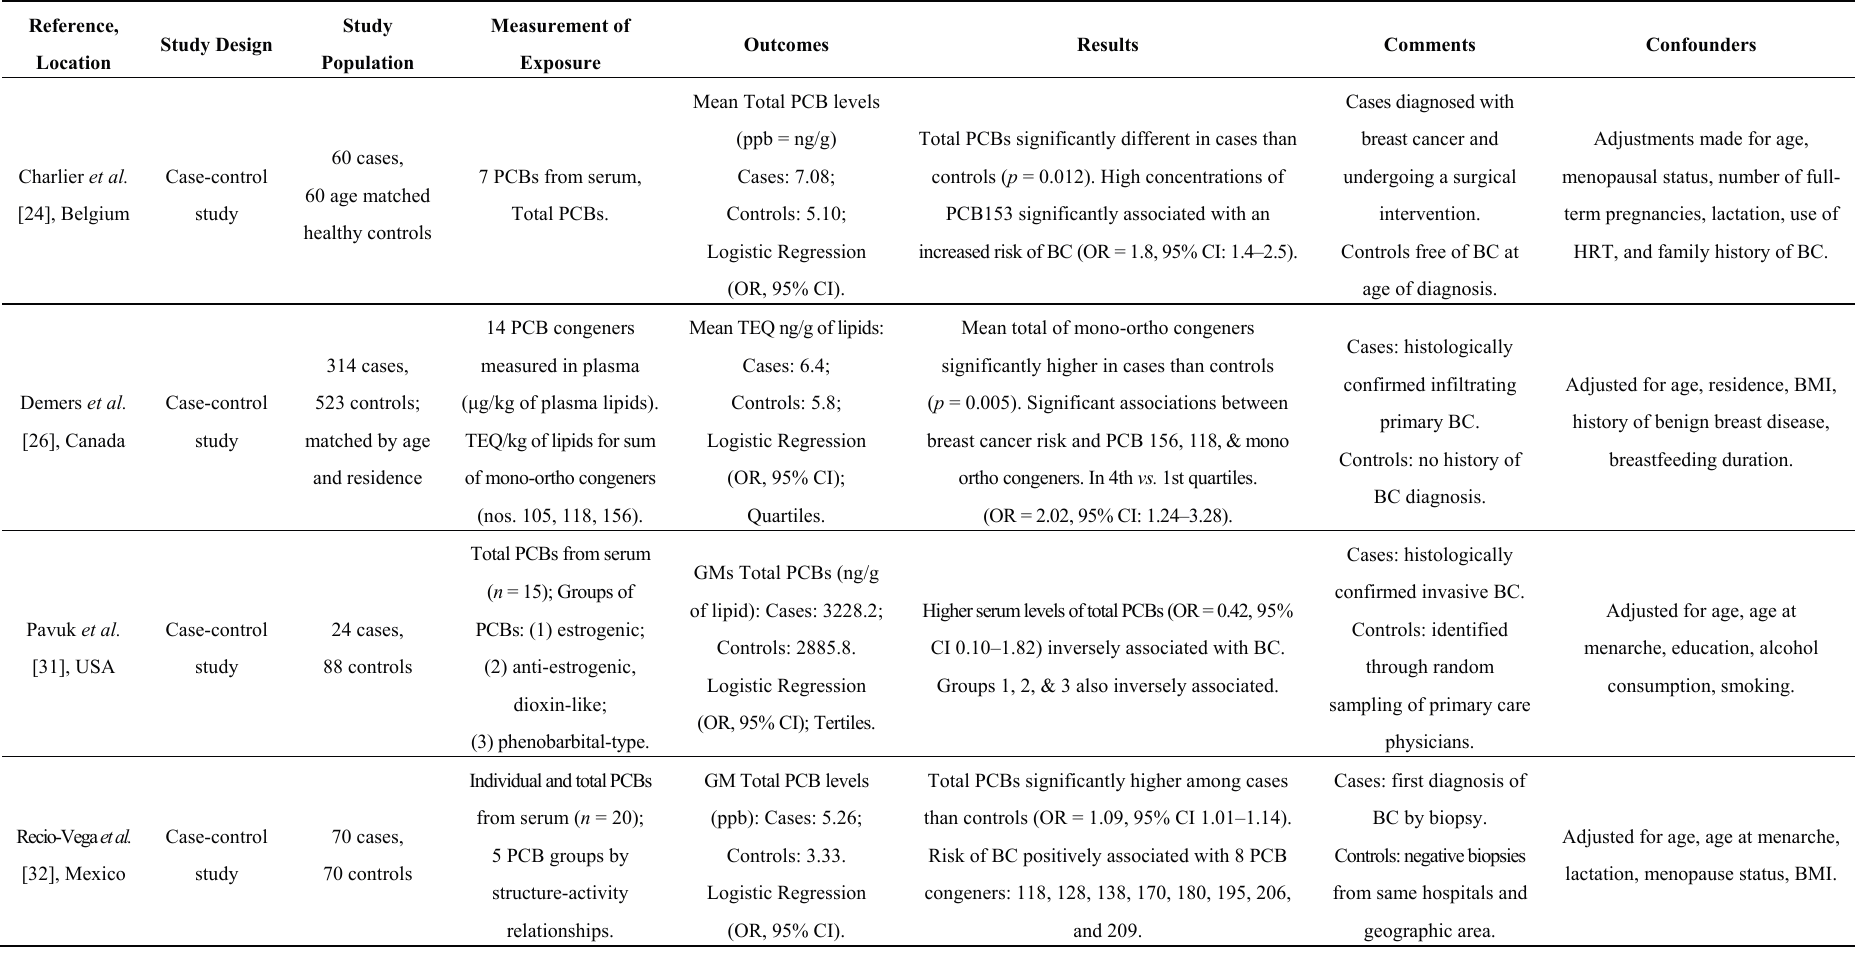
Table 1. Epidemiological studies of the association between exposure to PCBs and risk of breast